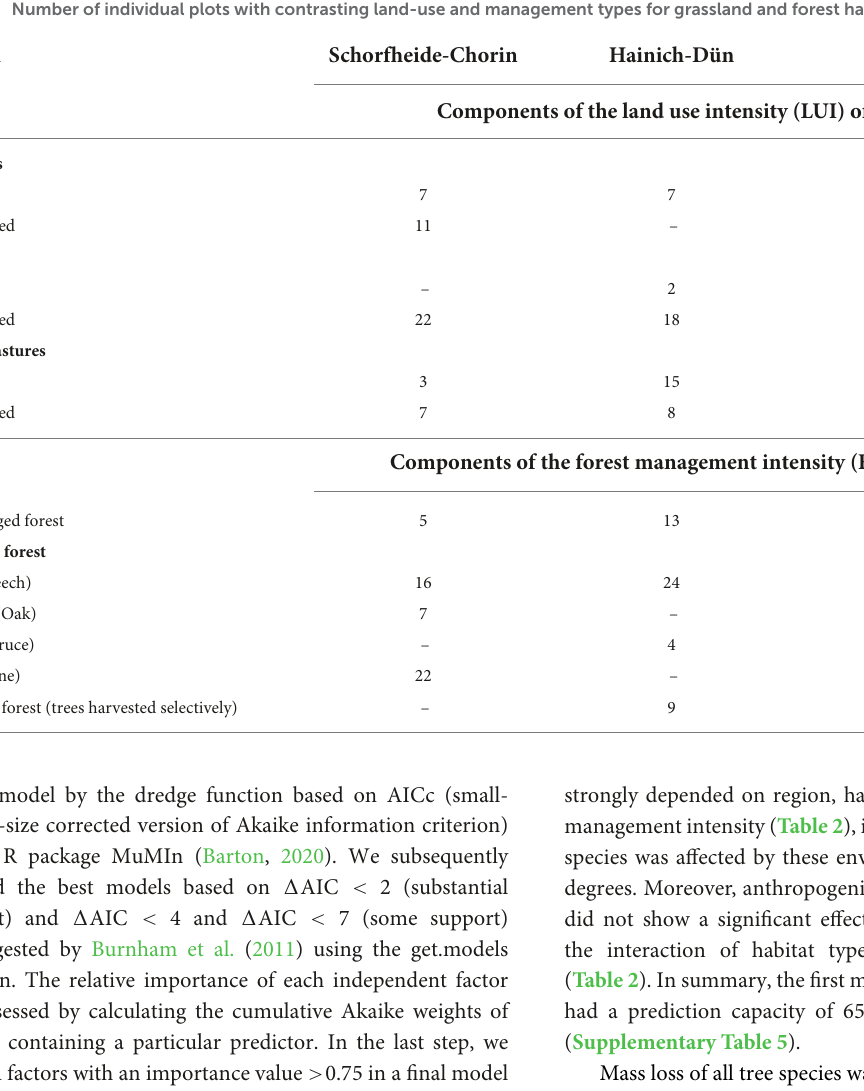
had a prediction capacity of 65%, including the interactions ( Supplementary Table 5